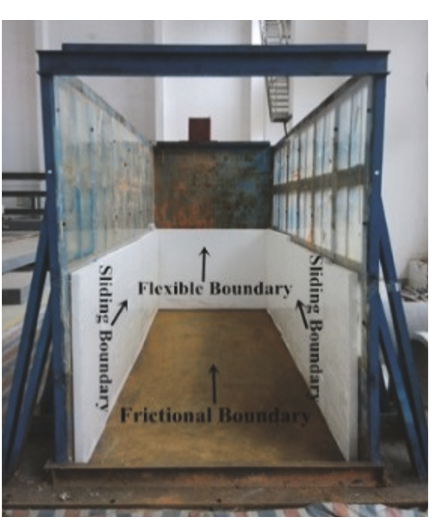
Figure 2: Treatment of model boundary